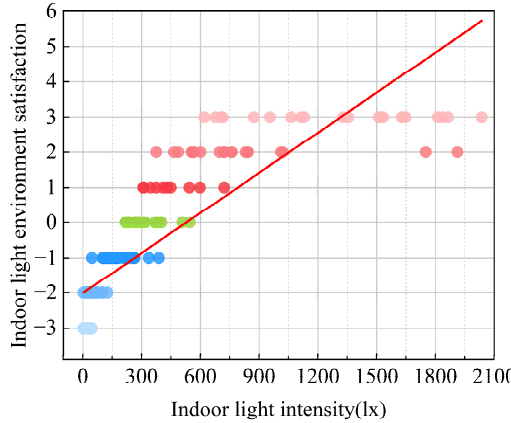
Figure 15. The relationship between indoor light intensity and satisfaction.